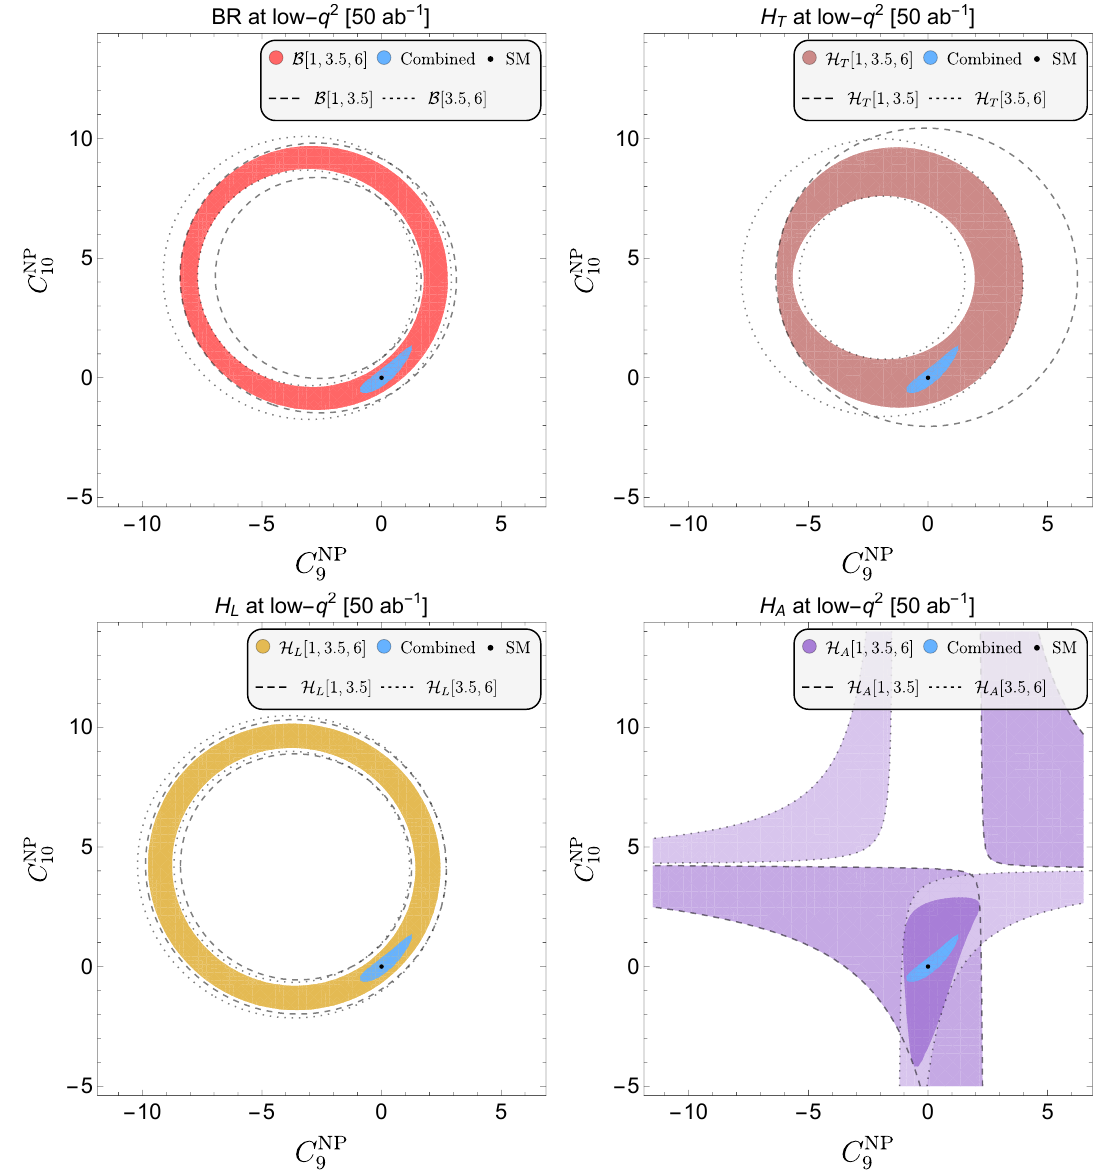
Figure 3 . Bounds from individual measurements of low- q 2 branching ratio, H T , H L and H A . In each case we show the constraints from the two low- q 2 bins and from their combination. See the caption in (cid:12)gure 2 for further